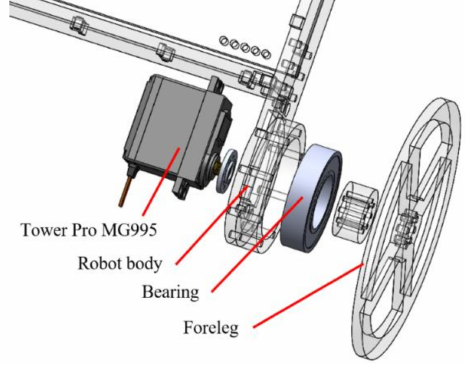
Figure 5. An exploded view of the foreleg structure of the dung beetle robot.